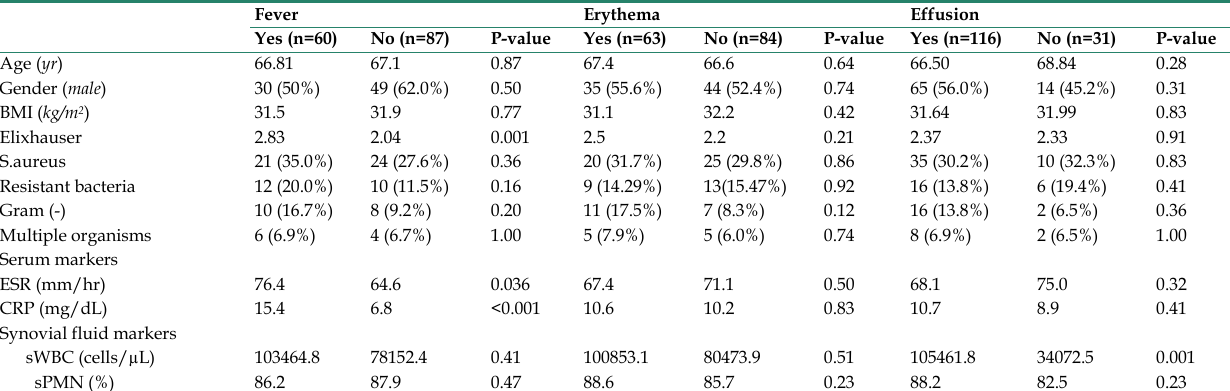
Table 3. Patient characteristics and bacterial virulence stratified by clinical presentation.